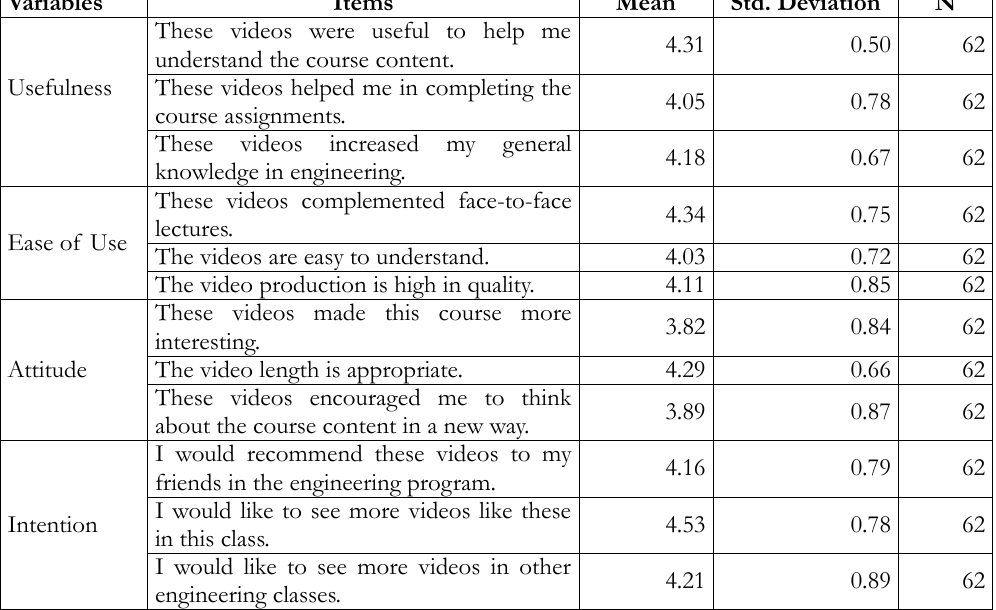
Table 3. Means and standard deviation of all questions with the four scales